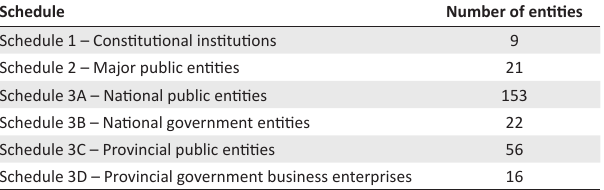
TABLE 3: Public Finance Management Act classification of state-owned entities. Schedule